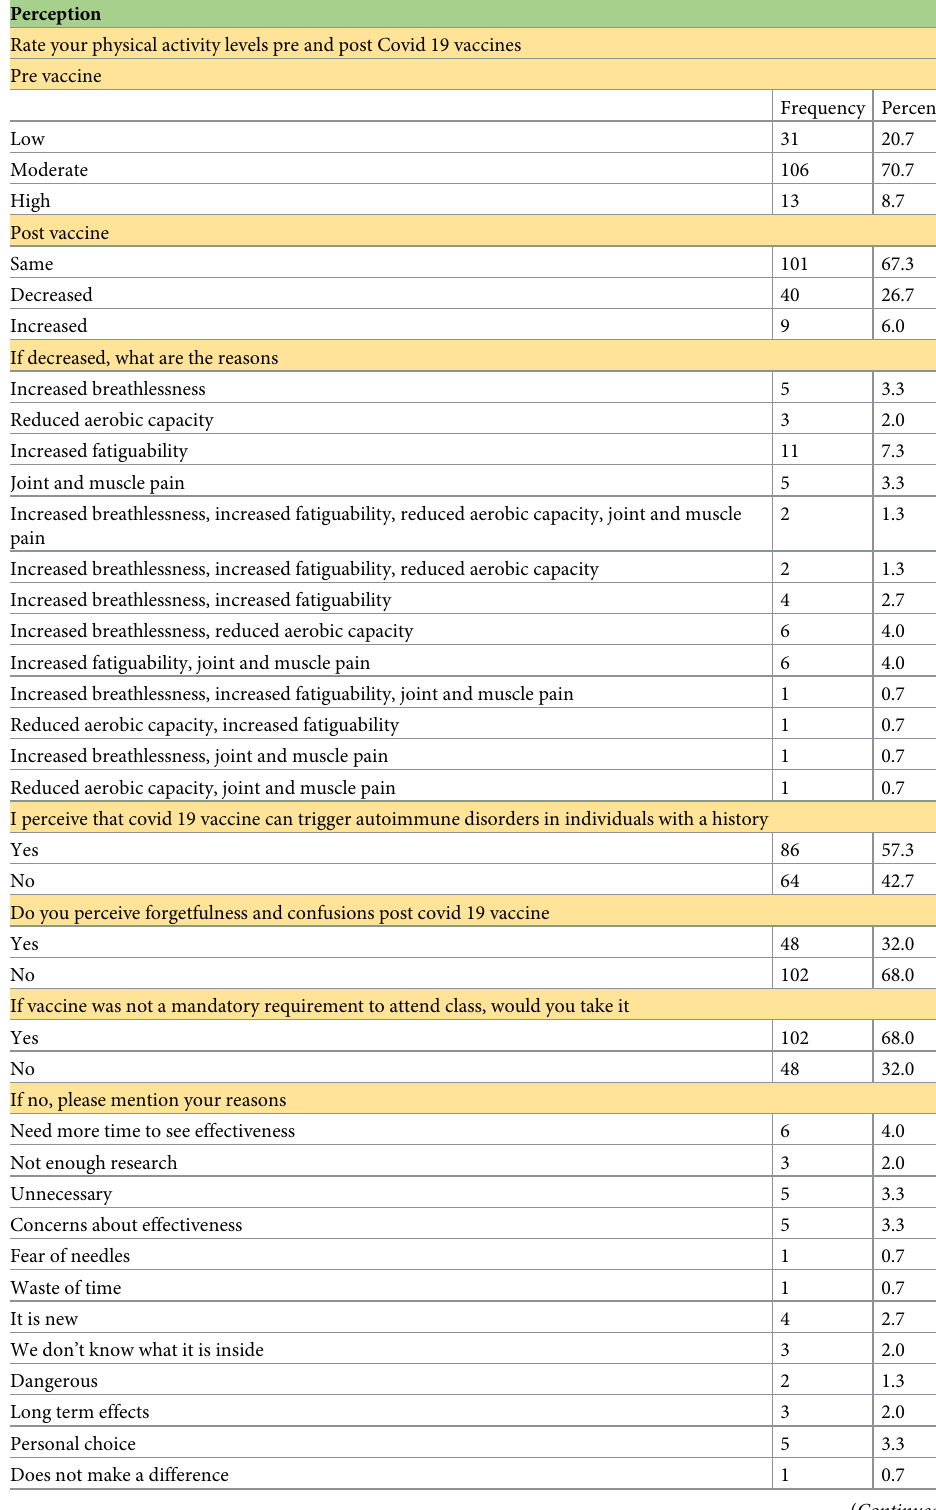
Table 4. Responses related to